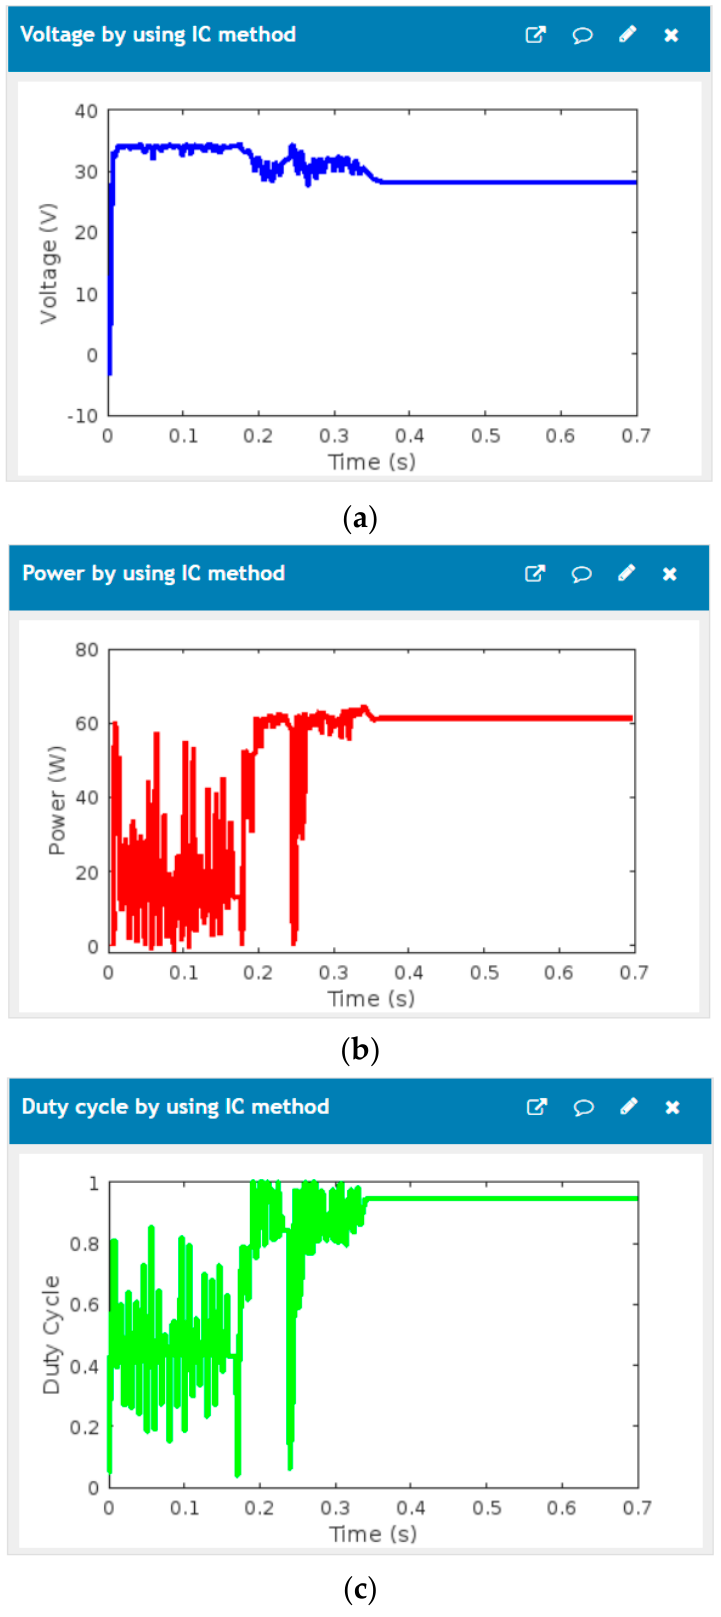
Figure 14. SCADA graphical user interface; ( a ) the voltage, ( b ) the power, and ( c ) the duty cycle using the incremental conductance method.